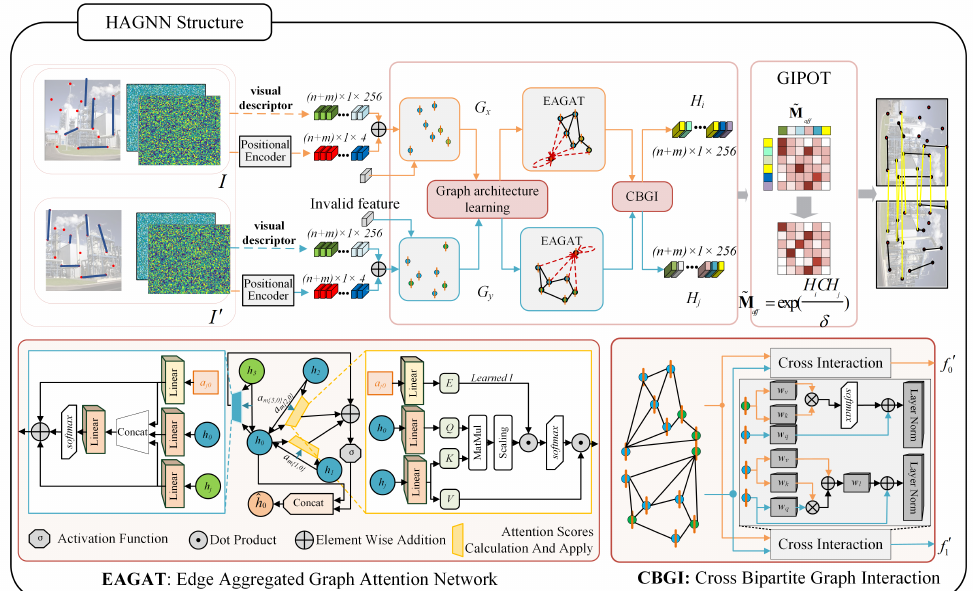
Figure 7. The overall structure of HAGNN. The first stage embeds the key points and line positions I and I (cid:48) into a high-dimensional vector, which generates G x and G y . Graph architecture learning is used to construct the graph. The two graphs can generate discriminative features through EAGAT and CBGI. The second stage computes the affinity matrix and the assignment matrix between two sets H i and H j and uses the assignment matrix to find matches and filter